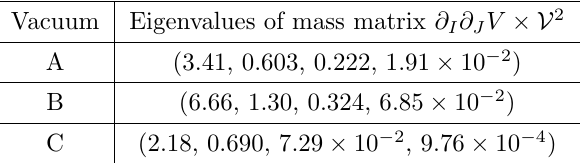
Table 2 . Mass eigenvalues of normalized scalar potential (cid:15) in M Pl = 1 unit. Note that we have diagonalized the mass matrix V 2 @ I @ J V by taking the linear combinations of the basis and the eigenvalues are displayed in the descending